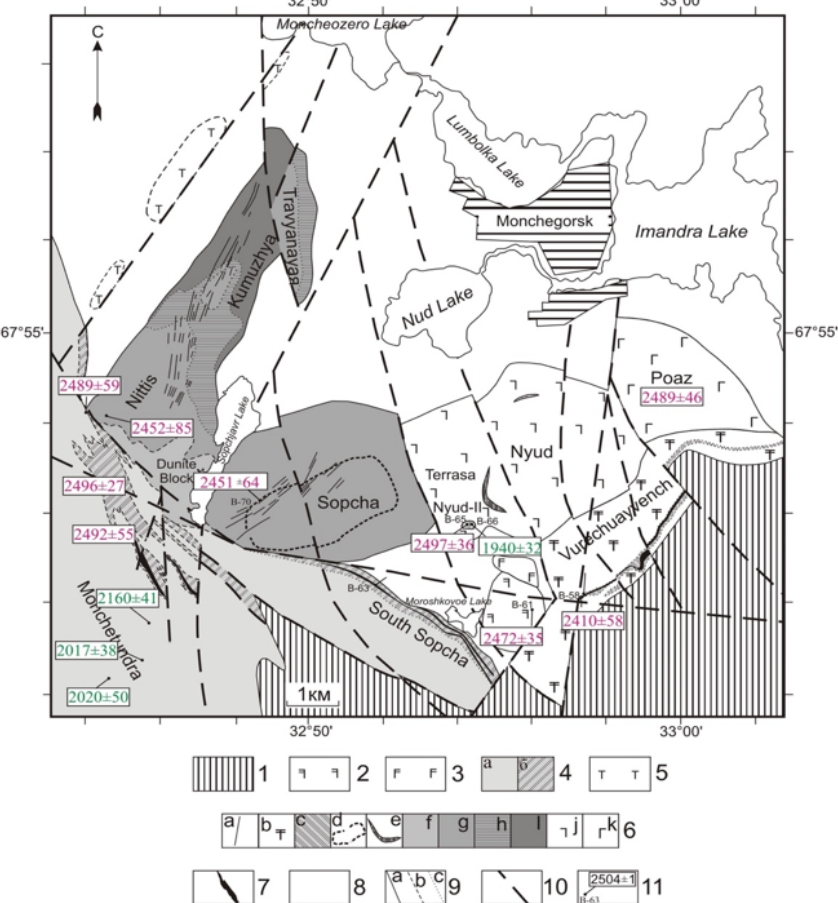
Figure 3. General geological map of Monchegorsk region with results of Sm-Nd geochronological studies (modified after [37]). Paleoproterozoic formations (1–6): 1—Imandra-Varzuga volcanic-sedimentary riftogenic structure; 2—metagabbronorite and metanorite of Lake Moroshkovoe massif; 3—quartz metagabbro of “10 anomaly” massif; 4—Monchetundra massif: (a) leucocratic metagabbro, metagab- bronorites and anorthosites from upper zone and (b) metanorites and metaorthopyroxenites from the lower zone; (5) gabbronorites of Kirikha massif; (6) Monchepluton: (a) sulfide veins, (b) “330 horizon” of Sopcha, (c) metagabbronorites (d) metaplagioclasites of Vurechuayvench massif, (e) Nyud “critical horizon”, (f) gabbronorites, (g) norites, (h) orthopyroxenites, (i) orthopyroxenites and harzbur- gites interbedding, (j) harzburgites, (k) dunite block; (7) horizons of low-sulfide PGE mineralization; (8) Archean metamorphic formations of Kola Block; (9) geological boundaries: reliable, (b) inferred, (c) facies; (10) faults; (11) location of samples, their numbers and results of